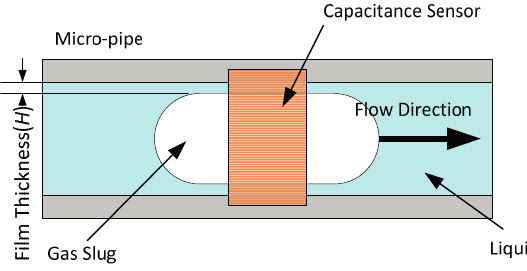
Figure 7. The film thickness between gas phase and the inner wall of